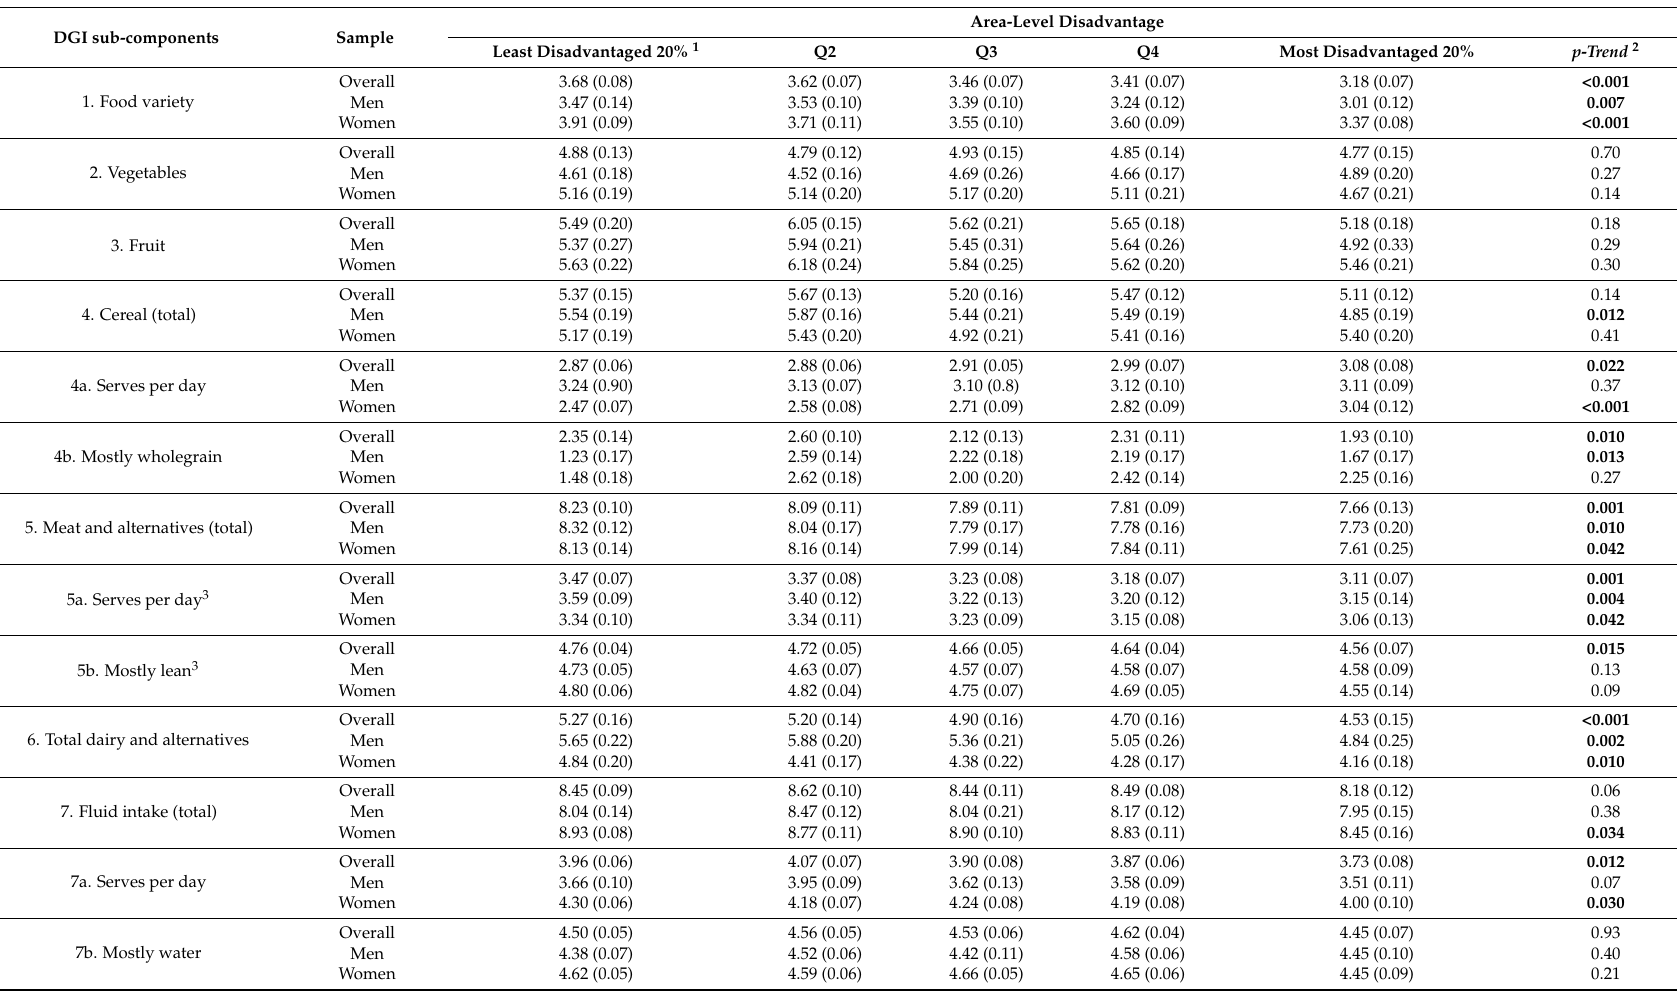
Table 1. Dietary Guideline Index (DGI) sub-components by area-level disadvantage in men ( n = 2356) and women ( n = 2519) from the 2011–13 Australian National Nutrition and Physical Activity